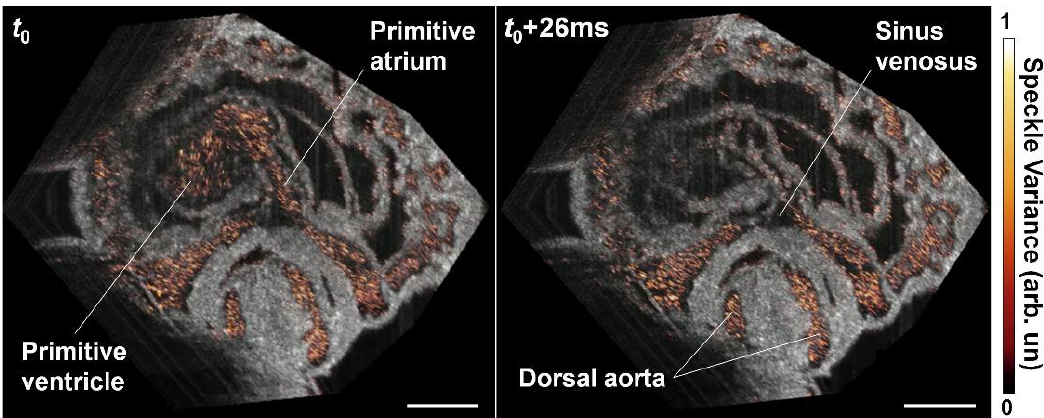
Figure 9. 4-D OCT angiography of the beating heart in E8.5 mouse embryo showing the well-separated blood circulations by speckle-variance contrast. Scale bars are 150 µm. Reproduced with permission from [46].